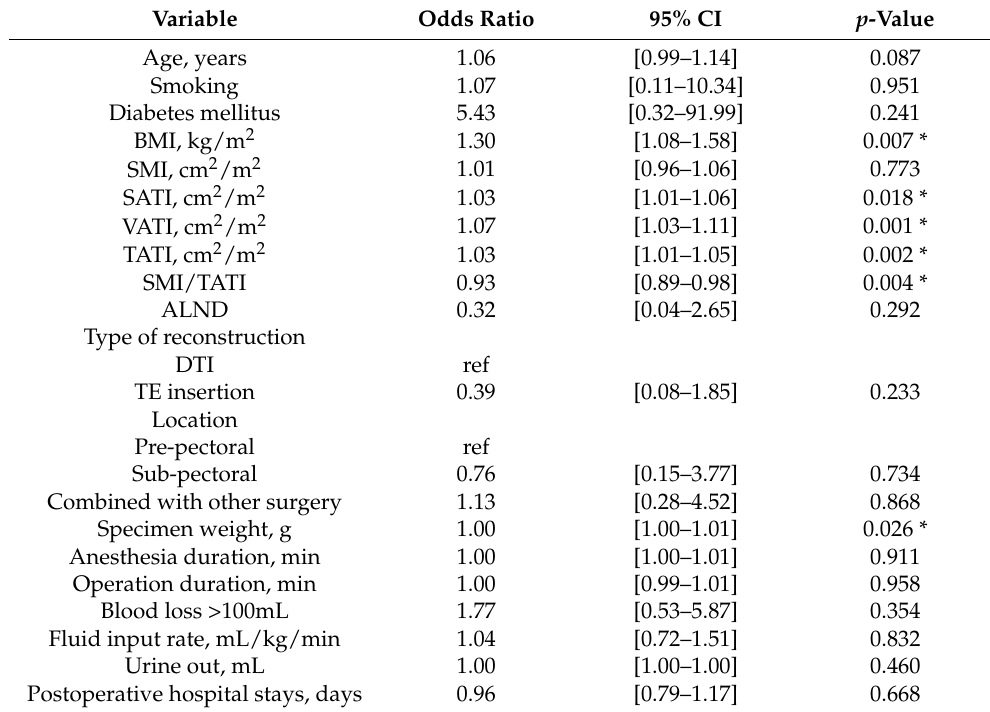
Table 4. Univariate analyses of risk factors for NAC ischemia after RNSM with IBR.